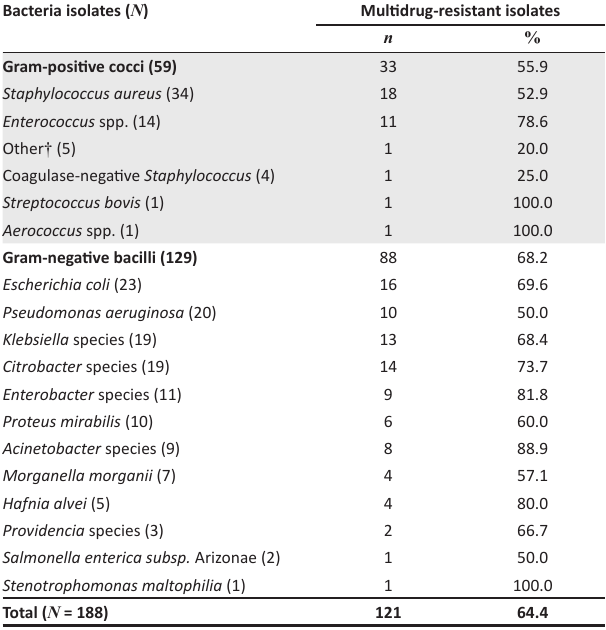
TABLE 3: Bacterial aetiological agents of infected diabetic foot ulcers in tertiary healthcare facilities in Osun state, Nigeria, July 2016 to April 2017. Organism categories